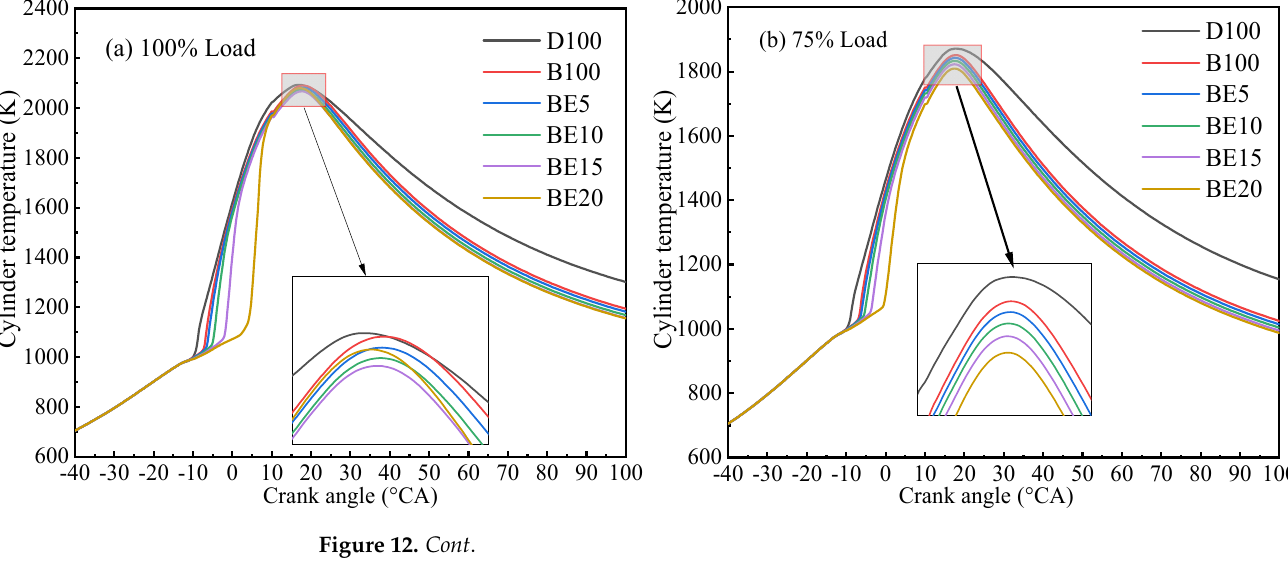
Figure 12. Comparison of cylinder temperature for different blends at different loads. ( a ) 100% Load, ( b ) 75% Load, ( c ) 50% Load, ( d ) 25% Load. Table 5 indicates the in ‐ cylinder temperature distribution field of different fuels at full engine load. It can be seen that the ethanol addition decreases the localized higher temperature zones due to higher latent heat vaporization of ethanol. Moreover, the oxy ‐ gen content in biodiesel also has a positive effect on improving the combustion character ‐ istics of the blend fuel. With the increase of ethanol addition ratios, the lower latent heat of vaporization of ethanol results in more heat loss. Therefore, the ethanol addition de ‐ creases the cylinder temperature. Table 5. Cylinder temperature distribution field in the cylinder at 100% load. − 8 °CA 0 °CA